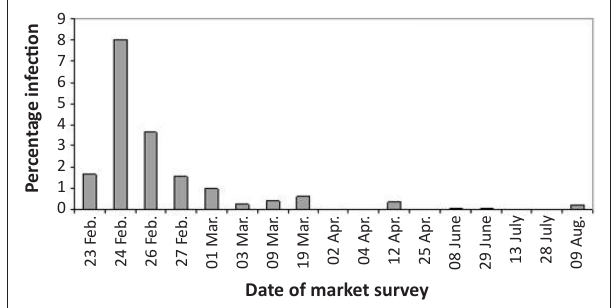
FIGURE 5: Prevalence of diseased fish recorded on the Katima Mulilo Open Market between February and August